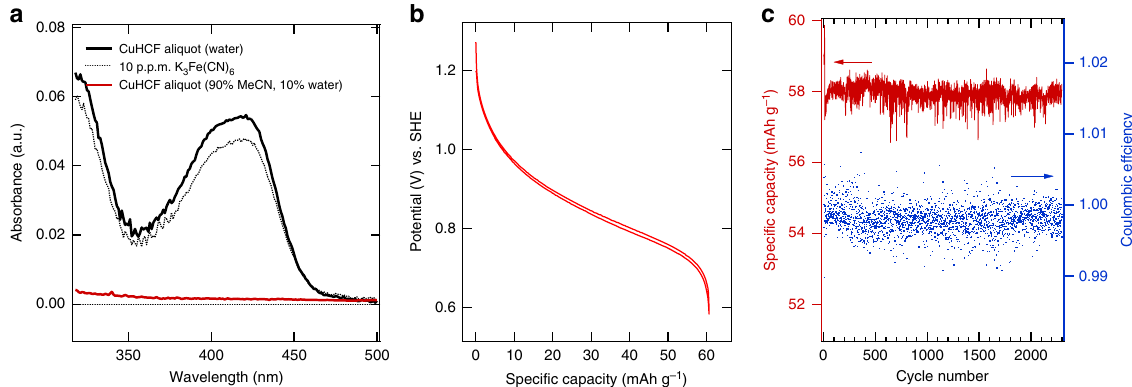
Fig. 5 Dissolution and half-cell tests of CuHCF in co-solvent electrolyte. a The UV-vis spectra of aliquots of water and the 90% MeCN + 10% water cosolvent electrolyte, in which a CuHCF electrode was stored at room temperature for at least 48 h. A 10 p.p.m. K 3 Fe(CN) 6 standard sample is measured for comparison. The peak at 420 nm corresponds to the dissolved Fe(CN) 6 3 – . No dissolution is observed for the co-solvent electrolyte. b The reaction potential pro fi le of the CuHCF cathode at a 1C rate with the co-solvent electrolyte. c The cycle life and coulombic ef fi ciency of the CuHCF electrode during 1C – 1C cycling between 0.6 and 1.15 V over 6 months. The noise is due to the precipitation of salt in the Ag/AgCl reference electrode frit, resulting in an inconsistent junction potential between the reference electrode- fi lling solution and